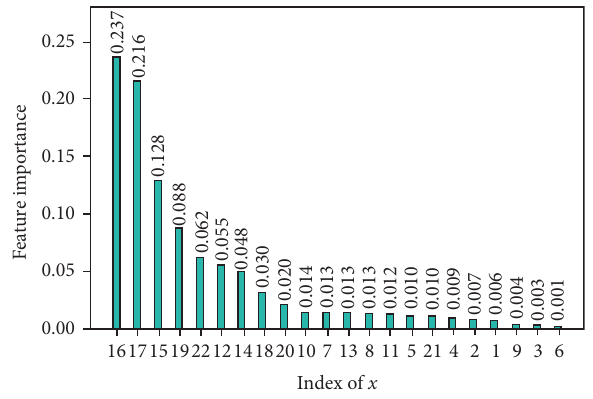
Figure 7: The importance ranking of